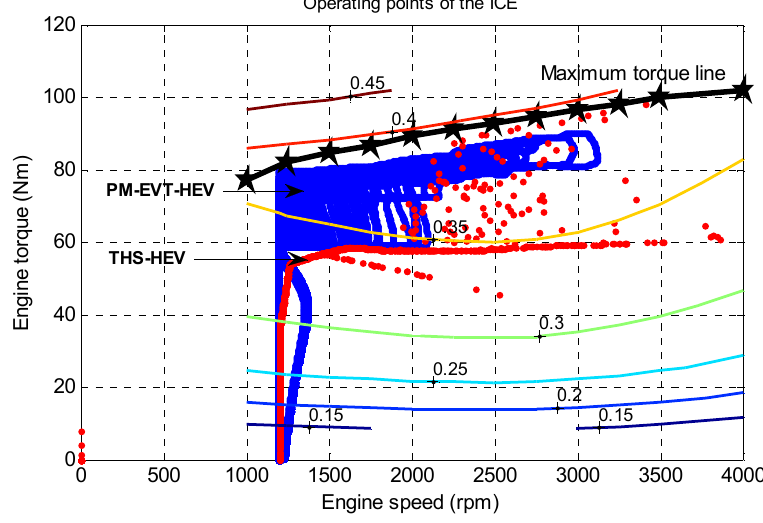
Figure 17. ICE Performance of PM-EVT-HEV and Prius THS-HEV: The torque/speed